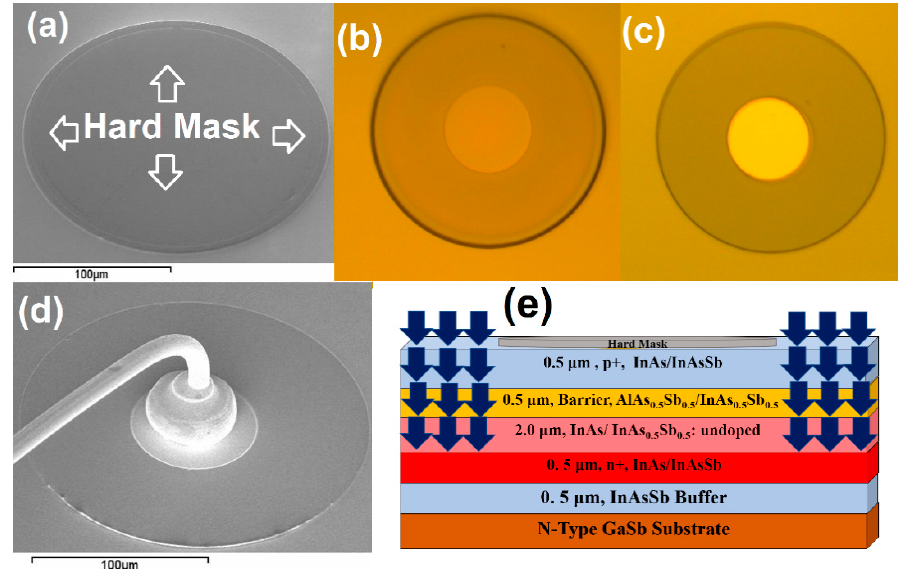
Figure 1. Images of the planar type-II superlattice (PT2SL) photodetector at different processing steps: ( a ) Scanning electron microscope (SEM) image and ( b ) optical micrograph of a circular diode covered by hard mask, ready for implantation, ( c ) optical micrograph after window opening to the top metal contact, and ( d ) SEM image after wire bonding, ready for test. ( e ) Schematic diagram of the device structure where the arrows showing the area of ion-implantation to isolate the diodes.